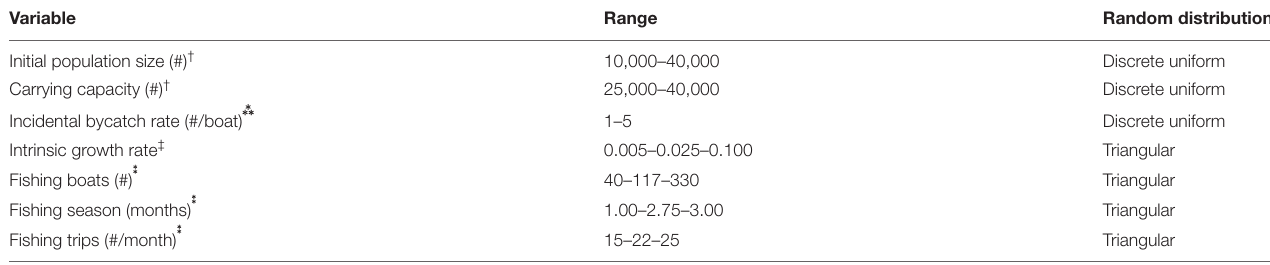
TABLE 1 | Range of values and random distributions for the Monte Carlo simulation of the loggerhead population-incidental bycatch system in the Gulf of Ulloa. Variable